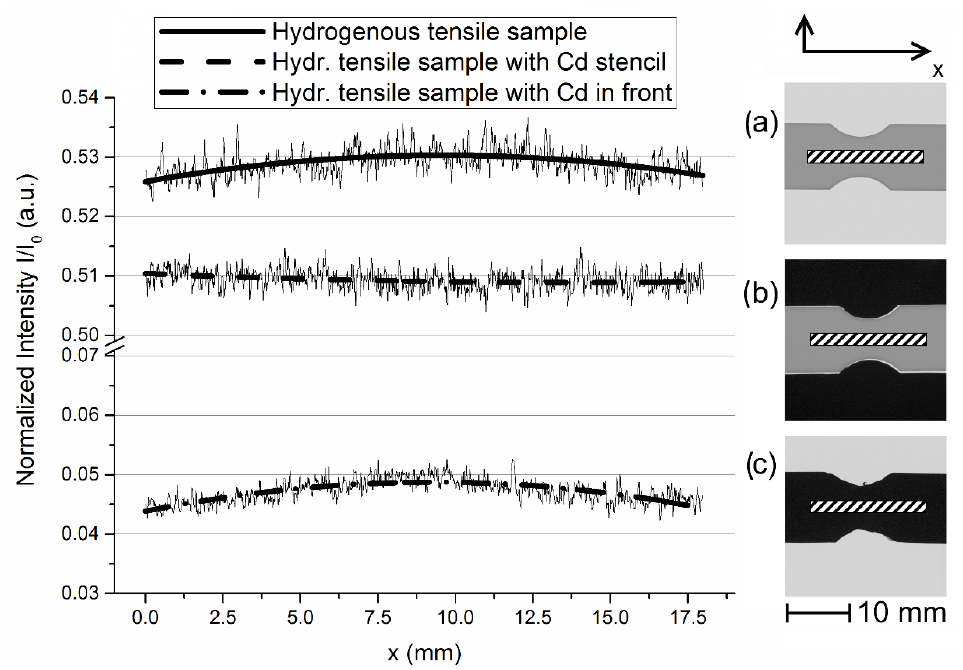
Figure 3. Intensity curves in ROIs shown as shaded areas in the radiographs ( a ), ( b ) and ( c ) on the right. Solid curves are Sovatzki-Golay fits (mathematical smoothing filter) of the measured intensities as a guide to the eye. ( a ) Hydrogenous tensile test sample, ( b ) hydrogenous sample framed by Cd stencil, ( c ) sample with Cd sheets in front.